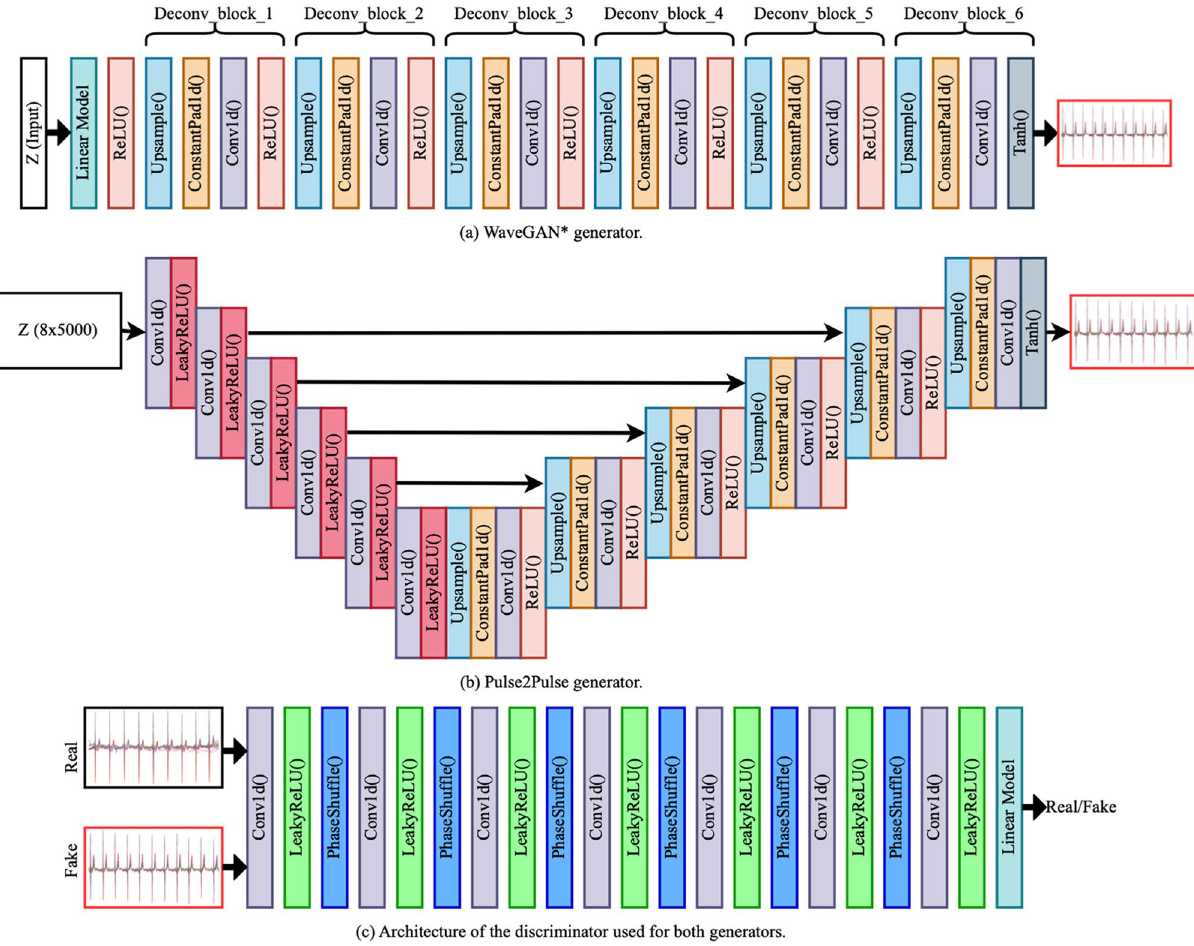
Figure 5. Model architectures of the generators and the discriminator used to generate synthetic ECGs. WaveGAN* uses a 1D noise vector with 100 points. Pulse2Pulse uses a 2D noise vector with size of 8 × 5000 as input, same as the output ECG